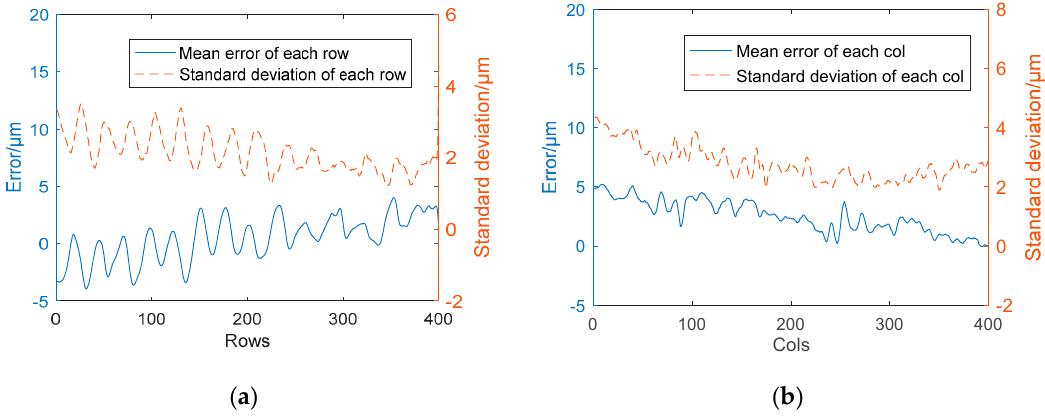
Figure 5. The variation tendency of 1.08 mm gauge block height error. ( a ) Measured error of each row; ( b ) Measured error of each col.